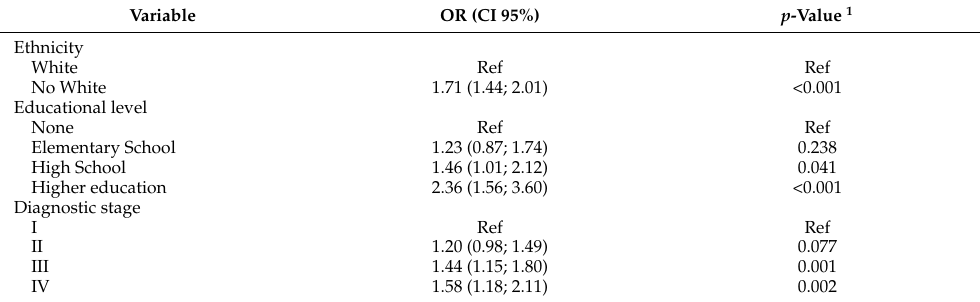
Table 3. Multivariate analysis of factors associated with lack of access to treatment in diagnosed women. Variable OR (CI 95%) p -Value 1 Ethnicity White Ref Ref No White 1.71 (1.44;